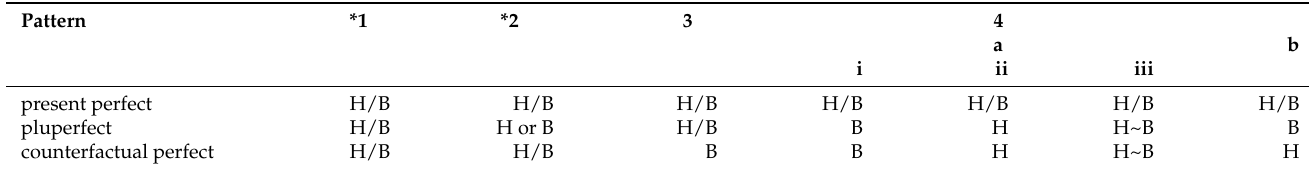
Table 2. Patterns of auxiliary distribution in central and southern dialects with person-based